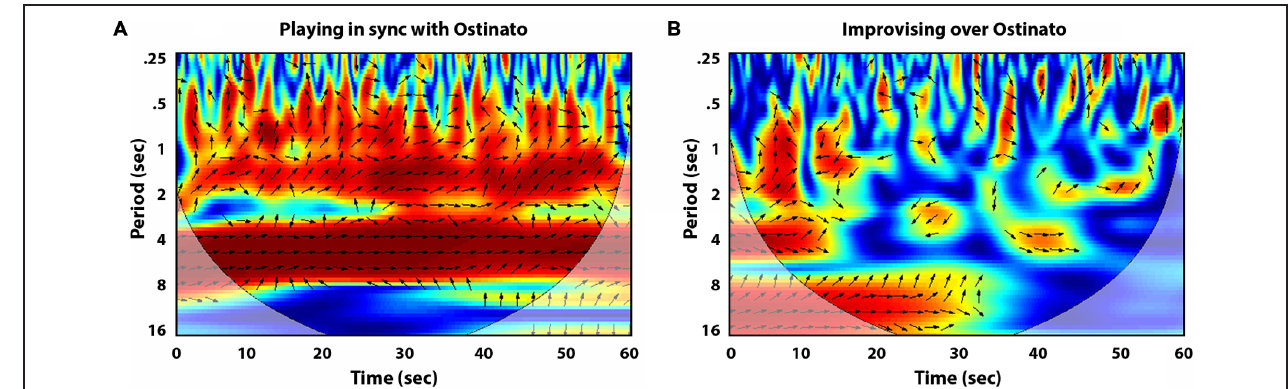
FIGURE 1 | Cross wavelet plots of the lateral movements of the musicians’ right forearms, displaying the strength of coherence at each period (red for high coherence = 1, dark blue for low to no coherence = 0), as well as relative phase angle (right arrows equal